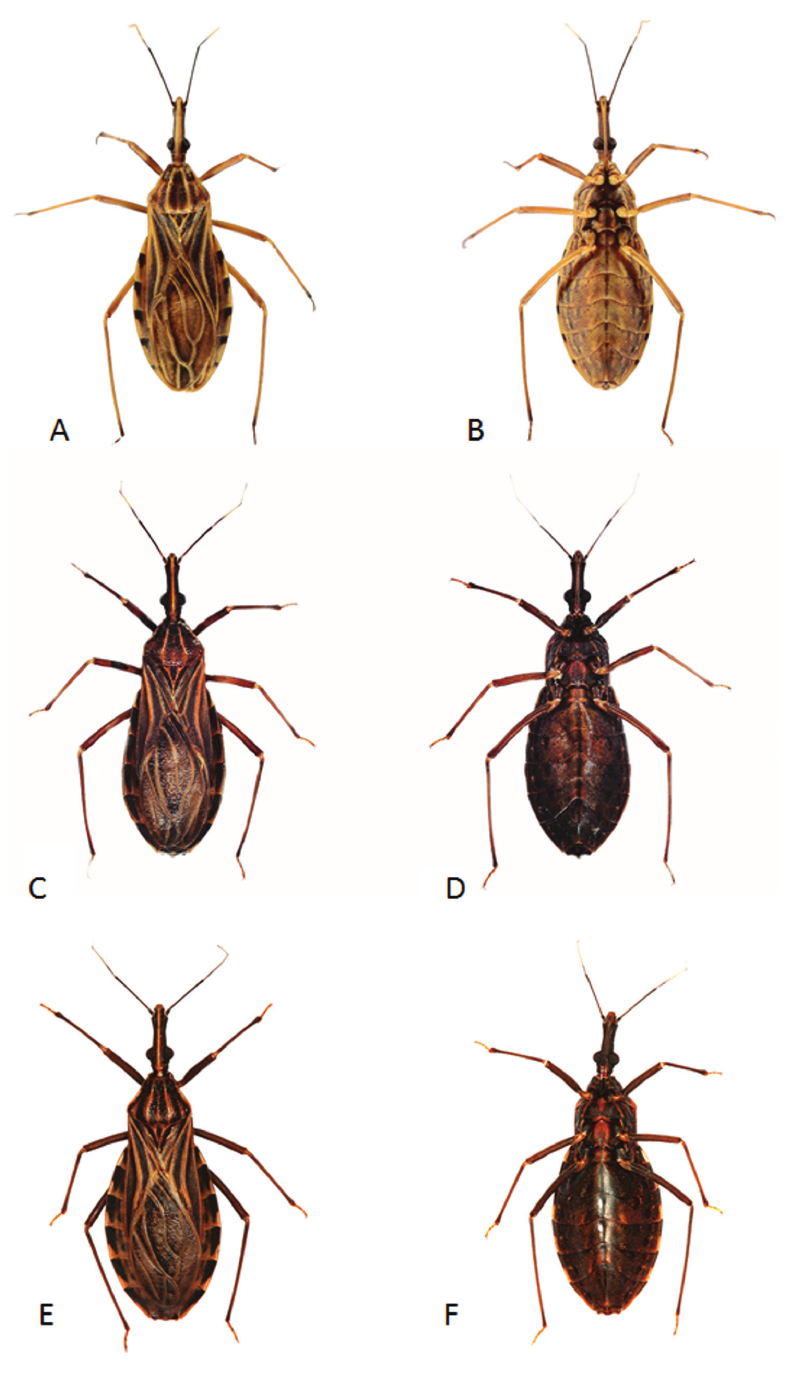
Figure 2. R. marabaensis sp. n. female ( A dorsal side B ventral side); R. prolixus female ( C dorsal side D ventral side); R. robustus female ( E dorsal side F ventral